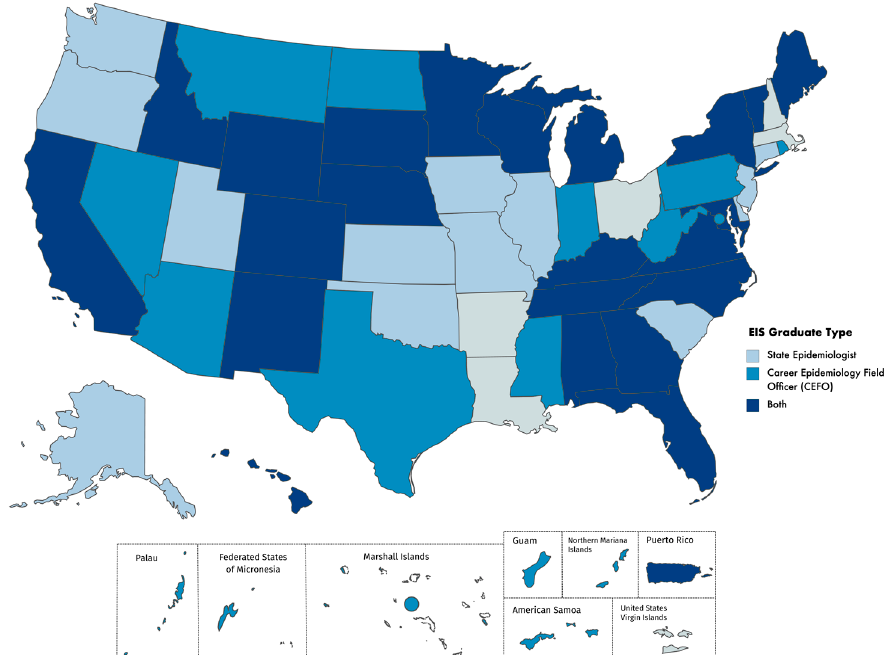
Figure 1. States in which an Epidemic Intelligence Service (EIS) Alumnus Has Served as the State Epidemiologist, Career Epidemiology Field Officer (CEFO), or both positions, 2000–2016. Note: CEFOs assigned to New York were all assigned to the New York City Department of Health and Mental Hygiene. All six U.S.-affiliated Pacific Islands are served by one CEFO.